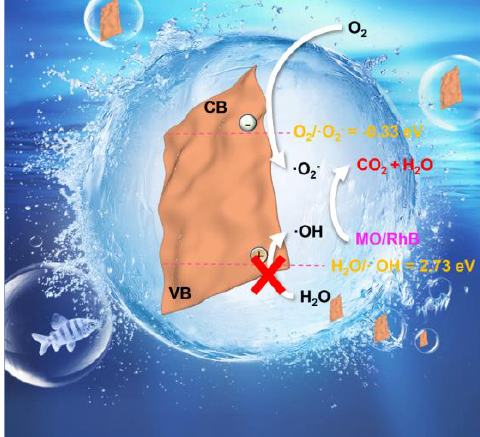
Figure 9. Schematic illustration of the proposed photocatalytic mechanism in the BFTOX powders.